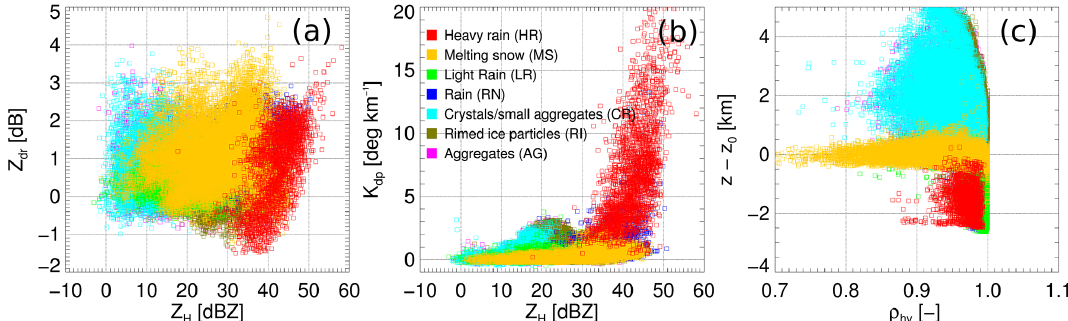
Figure 4. Three examples of two-dimensional projection of the seven clusters found in the data set. The clusters include observations collected in Davos (CH) and Ardèche (FR). (a) : Z DR vs. ρ hv ; (b) : Z H vs. K dp ; (c) : (cid:49)z vs. ρ hv . Note that some of the clusters are not fully visible in this two-dimensional projection because they are defined in a five-dimensional space. Table 3. Rainfall rate R [mmh − 1 ] associated with the three clusters appearing at positive temperatures. Some relevant quantiles ( Q 5%, Q 25%, Q 50%, Q 75%, Q 95%) of the full distribution are given here. The data used to build this table were collected during the HyMeX campaign. Cluster Interpretation Q 5% Q